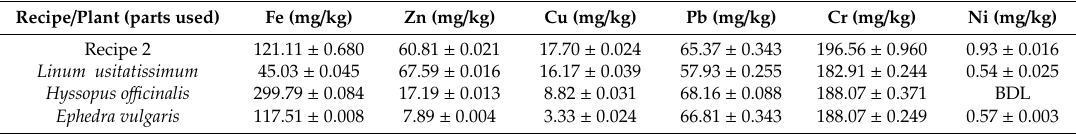
Table 5. Metals in herbal plants and in their Recipe 2 e.g., Cd, Ni, Fe, Pb, Zn, Cu and Cr.